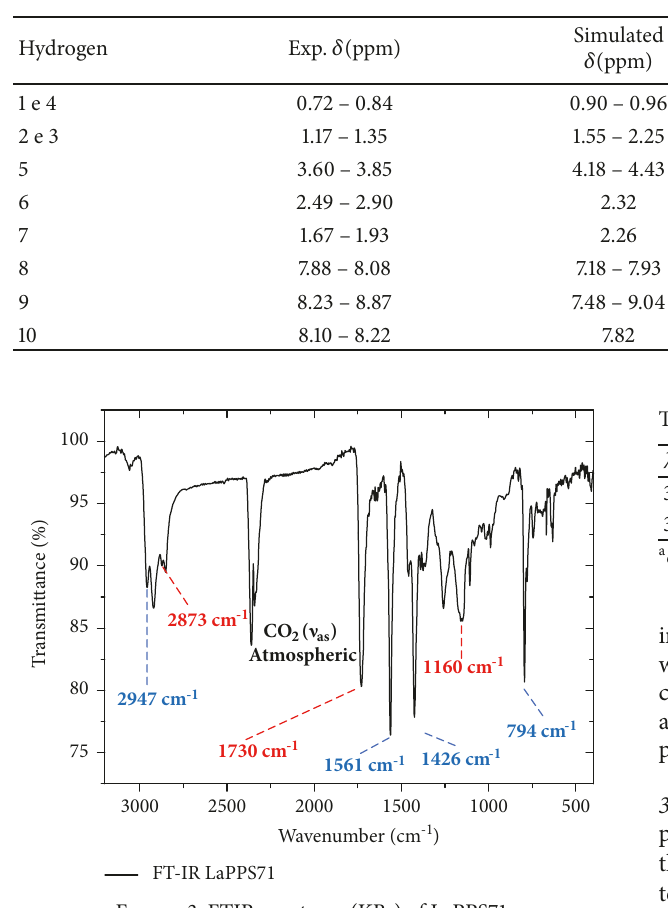
Figure 3: FTIR spectrum (KBr) of LaPPS71.